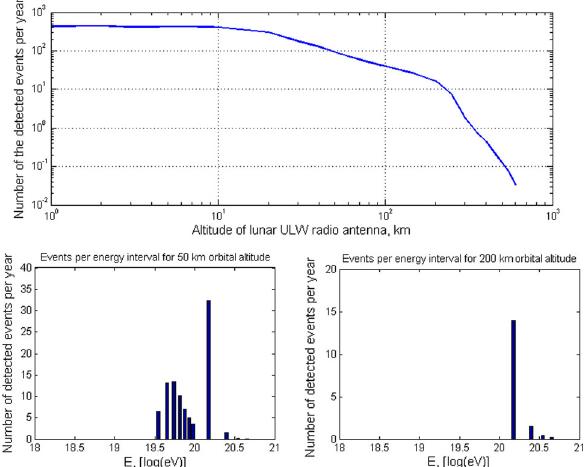
Fig. 5 The number of detected (per year) cosmic ray events for the energy E ≥ 10 18 eV with the flux parametrization of the Auger Collab- oration [1]. Top, the total number detected events as a function of lunar antenna orbital altitude; Bottom, the detected events per energy interval for the lunar antenna of 50km-high orbit (left) and 200km-high orbit